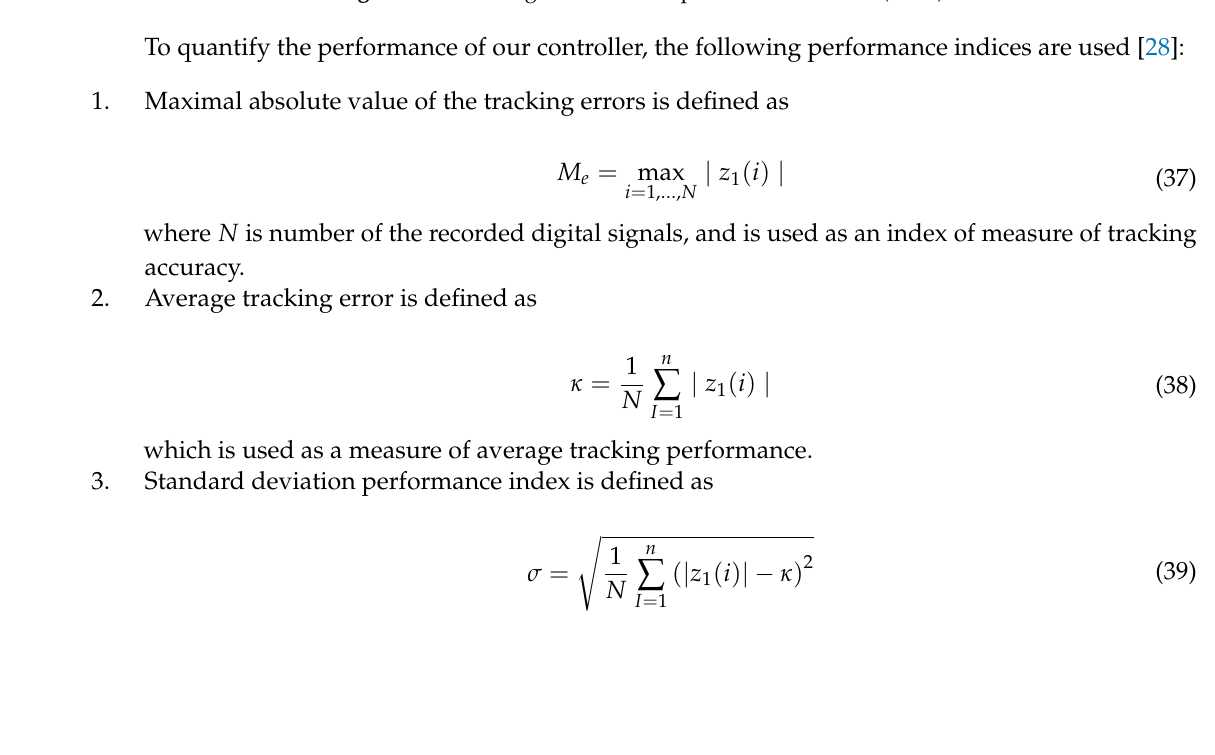
Figure 3. Block diagram of the adaptive robust control